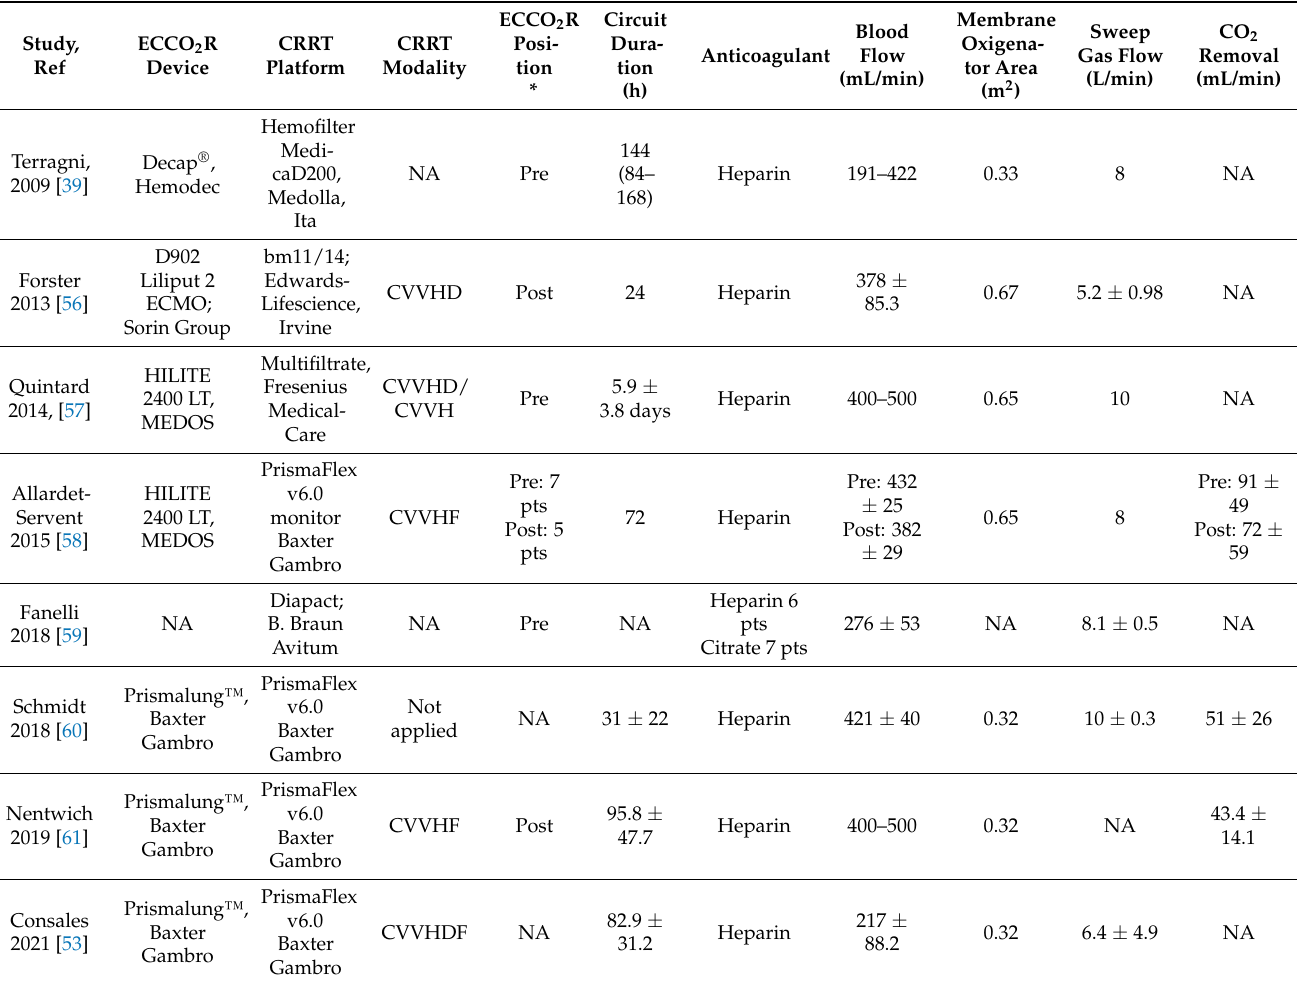
Table 2. Devices and operative parameters of studies reporting use of combined ECCO 2 R–CRRT